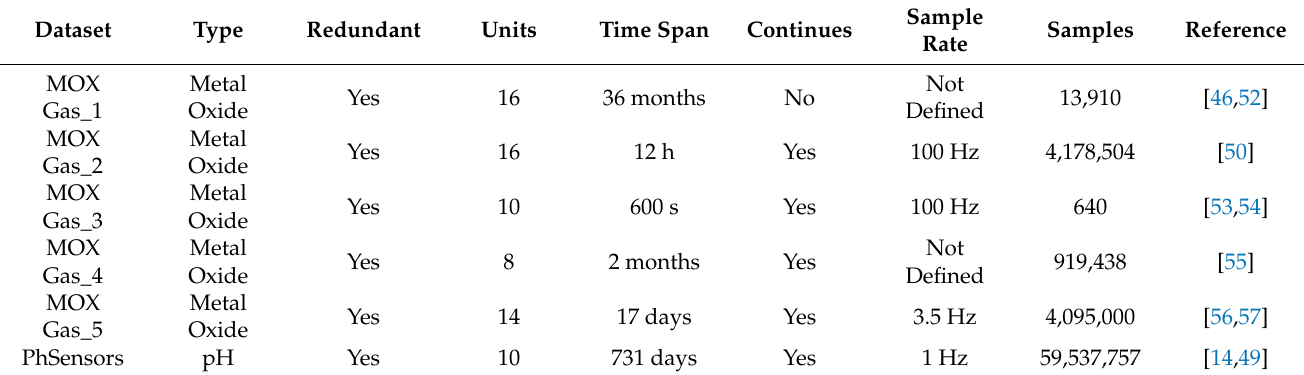
Table 1. Publicly available datasets with redundant sensors that were